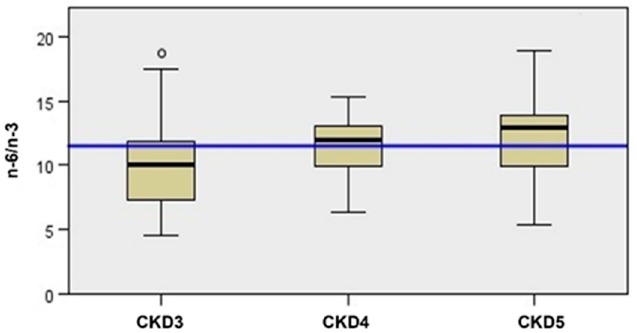
Figure 2. The n-6/n-3 trend data according to CKD stage, blue line = median, n = 56, ( n = 19 in CKD3, n = 25 in CKD4, n = 12 in CKD5). Kruskal–Wallis’s analysis from median. ° = outliner patients.